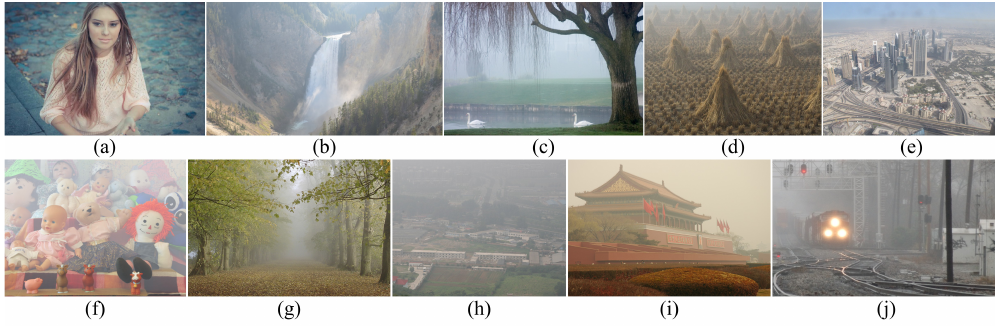
Figure 8. The test images used for the objective assessment of haze removal [1,4,5,16]: ( a – j ) are the real haze images to evaluate the performance of haze removal. Reproduced with permission from [1], IEEE, 2011, reproduced with permission from [4], IEEE, 2014, reproduced with permission from [5], IEEE, 2016, reproduced with permission from [16], IEEE, 1969.